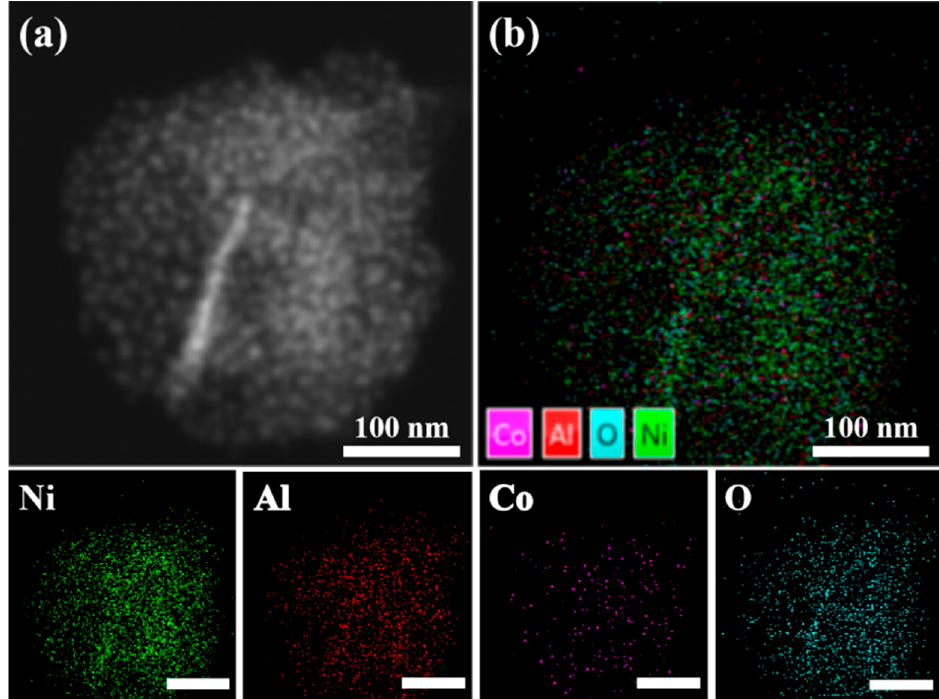
Figure 7. TEM image ( a ) and EDS mapping ( b ) of the NiCo 0.5 Al-R catalyst.